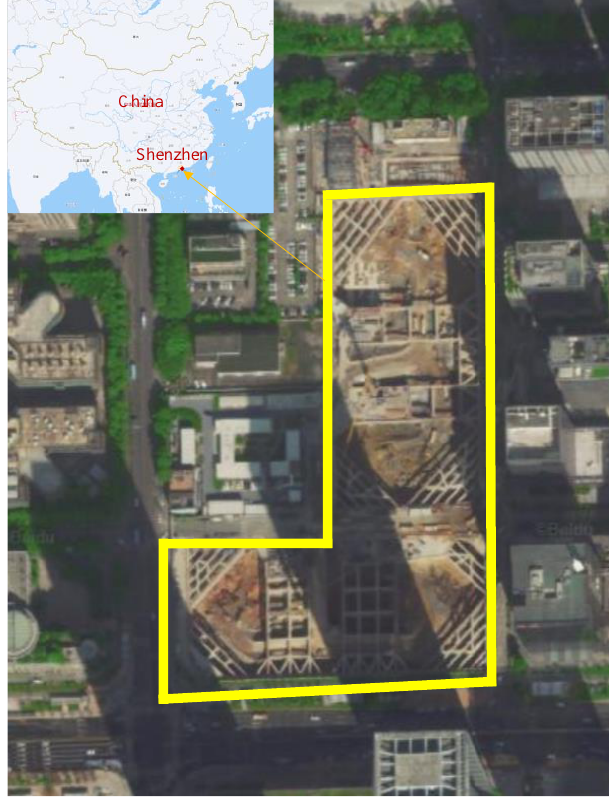
Figure 1. The site and foundation pits of the engineering project. (1) Gravelly clayey soil is maroon, gray – white, isabelline yellow, and other colors. It is in a plastic to hard-plastic state and contains 20 – 25% quartz gravel, which is the weath- ered residual soil of biotite granite. Some boreholes reveal that this layer is significantly kaolinized, and it collapses easily in water. This layer is widely distributed throughout the site, is 1.50~28.80 m thick, with an average thickness of 13.95 m, a top burial depth of 5.20~18.90 m, and a bottom depth of 13.50~42.40 m. The core recovery rate of this layer is 80 – 95%.